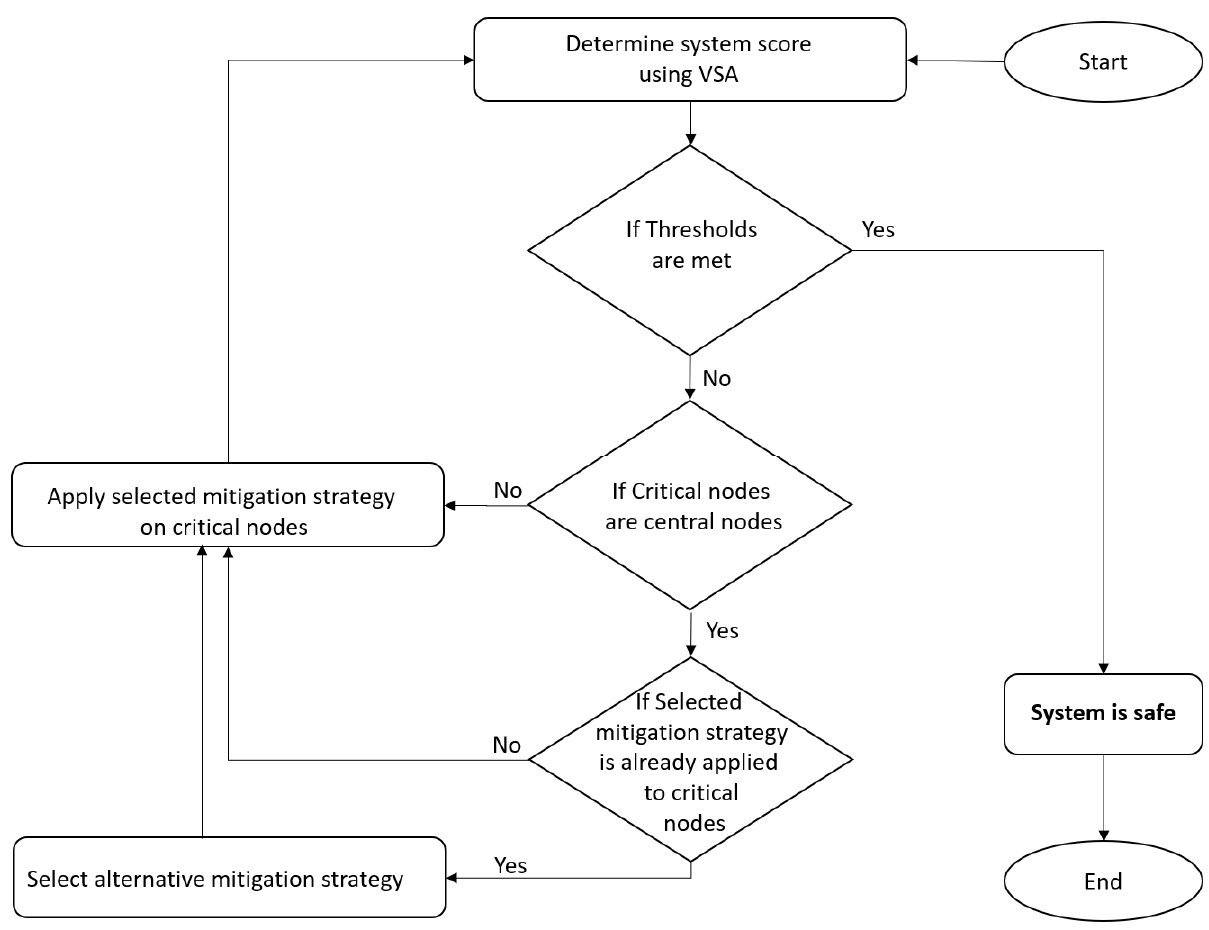
Figure 3. Mitigation strategy sequence.